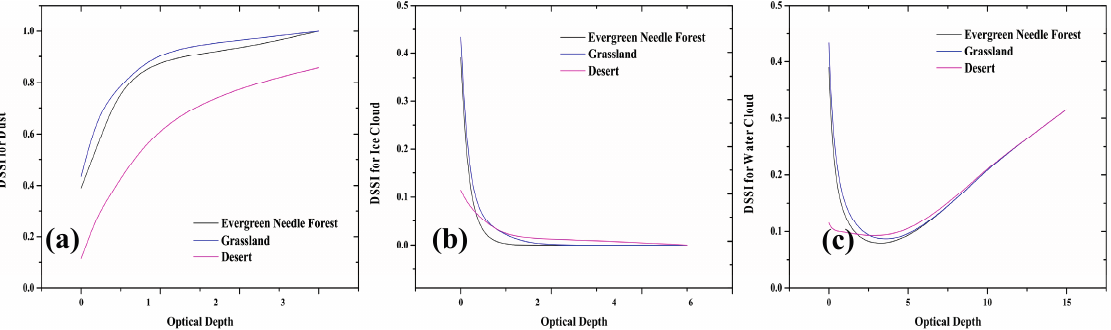
Figure 9. The effect of underlying surface type on DSSI under the conditions of ( a ) dust ( b ) ice cloud ( c ) water